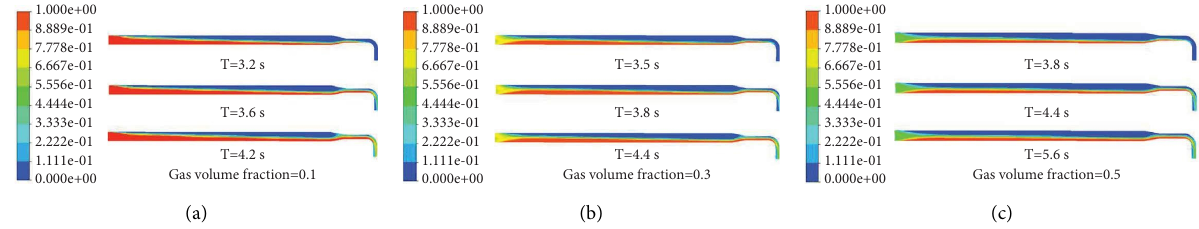
Figure 16: Diagram of the distribution of the water volume fraction in the pipeline at several typical moments. (a) Gas volume fraction � 0.1. (b) Gas volume fraction � 0.3. (c) Gas volume fraction � 0.5.